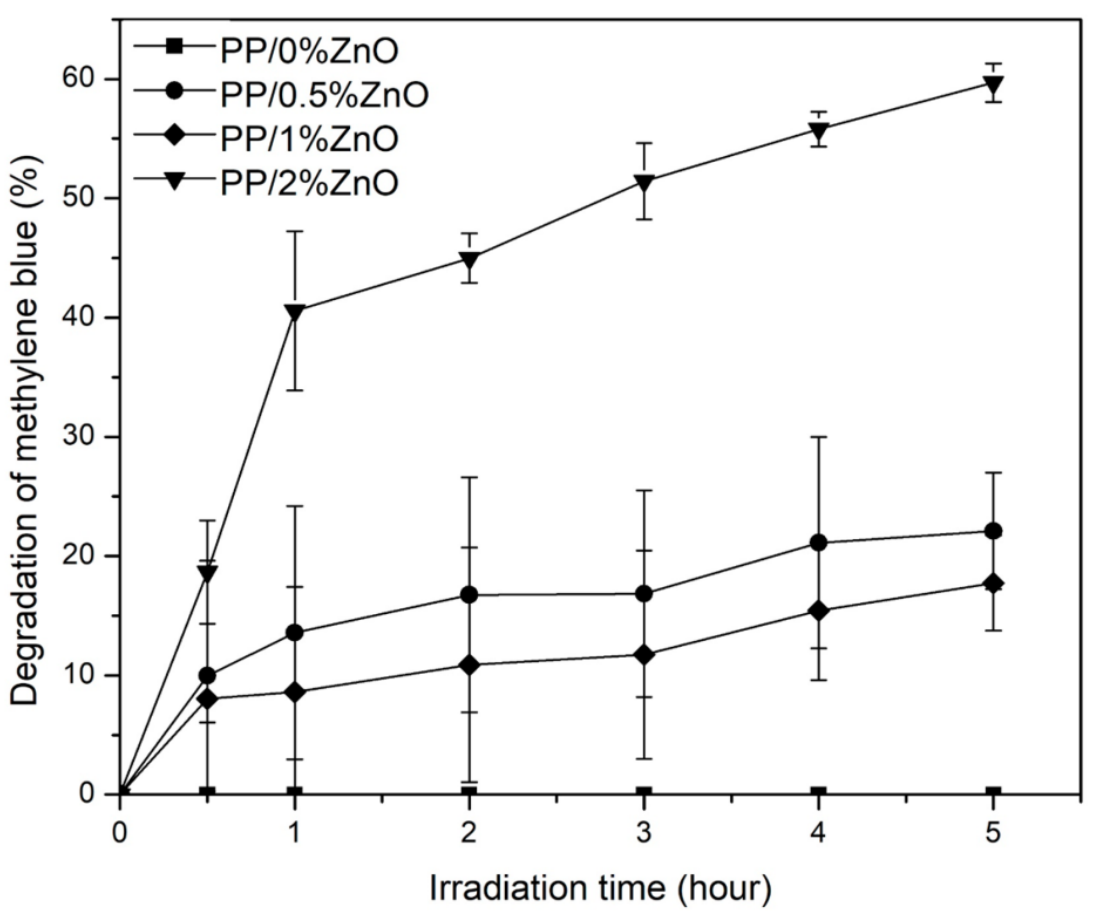
Figure 6. Photocatalytic degradation of methylene blue by using PP/ZnO nanocomposites as a catalyst. Reprinted from [48].